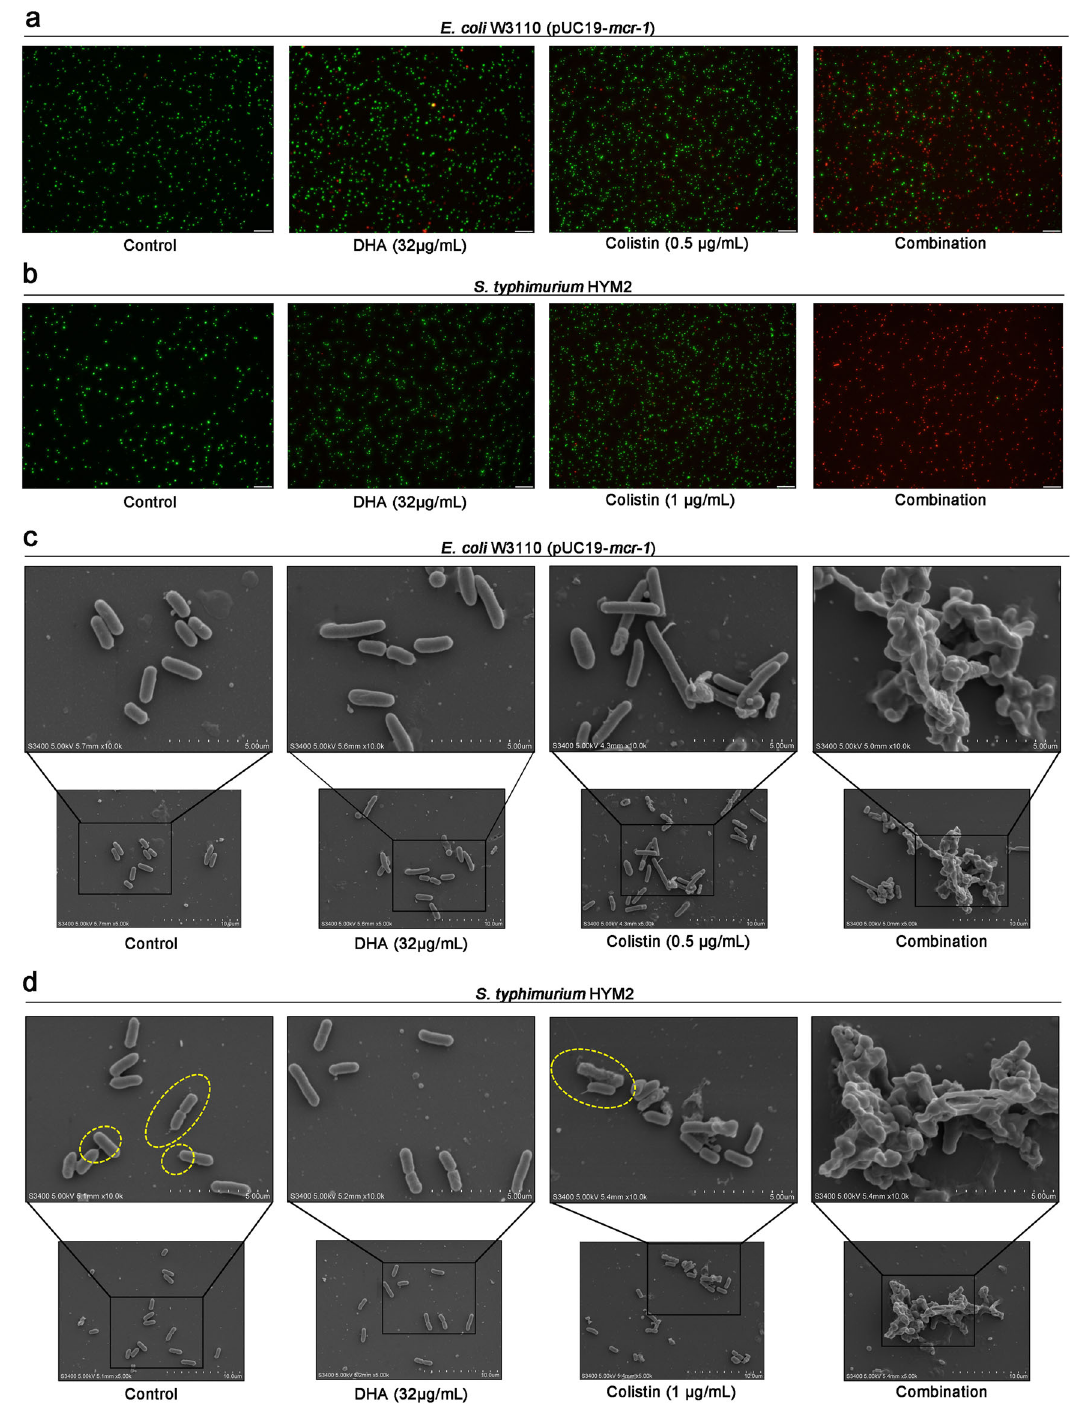
Fig. 3 DHA in combination with colistin effectively kills the tested bacteria. a , b Fluorescence labeling analysis for E. coli W3110 (pUC19- mcr-1 ) ( a ) and S. typhimurium HYM2 ( b ) were treated with DHA (32 µ g/mL), colistin (0.5/1 µ g/mL) the combination or control (bacteria without any treatment), and live bacteria were dyed green and dead bacteria were dyed red (scale bar = 50 μ m). c , d SEM analysis (scale bar = 5 μ m) for E. coli W3110 (pUC19- mcr-1 ) ( c ) and S. typhimurium HYM2 ( d ) was also performed with the above treatment (5.00 kV, bar = 5 μ M, 10 μ M). Only in the control group and 1 μ g/mL colistin treatment group observed the fi lamentous fl agella at both ends of the S. typhimurium (yellow dashed circles). The experiments were repeated three times independently, and representative data are